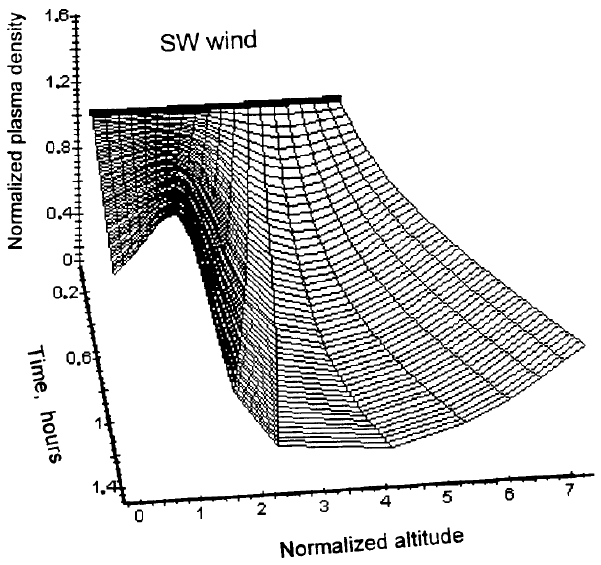
Fig. 7. Same as Fig. 5 but for the northwest PW vortex quadrant, i.e. the profile is representative of PW winds pointing SW. As seen, a very weak layer forms near 110km, while the ionization is de- creased at higher